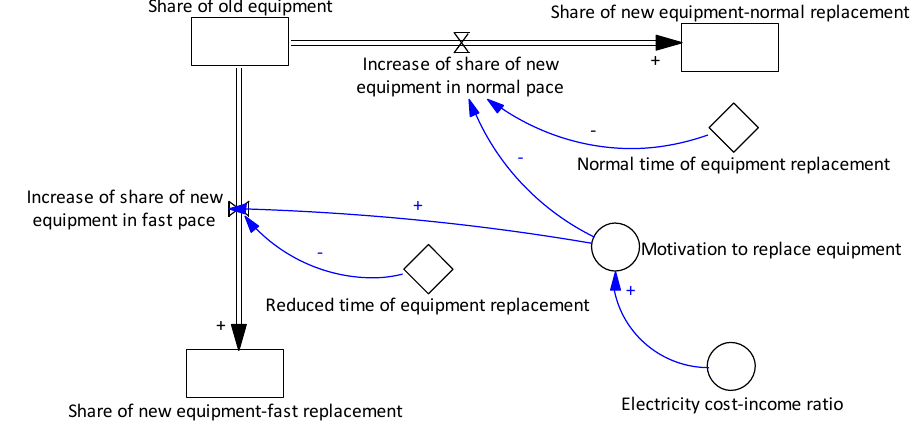
Fig. 4. A stock-and-flow diagram representing replacement of old equipment (light bulbs, electric appliances) with new equipment.